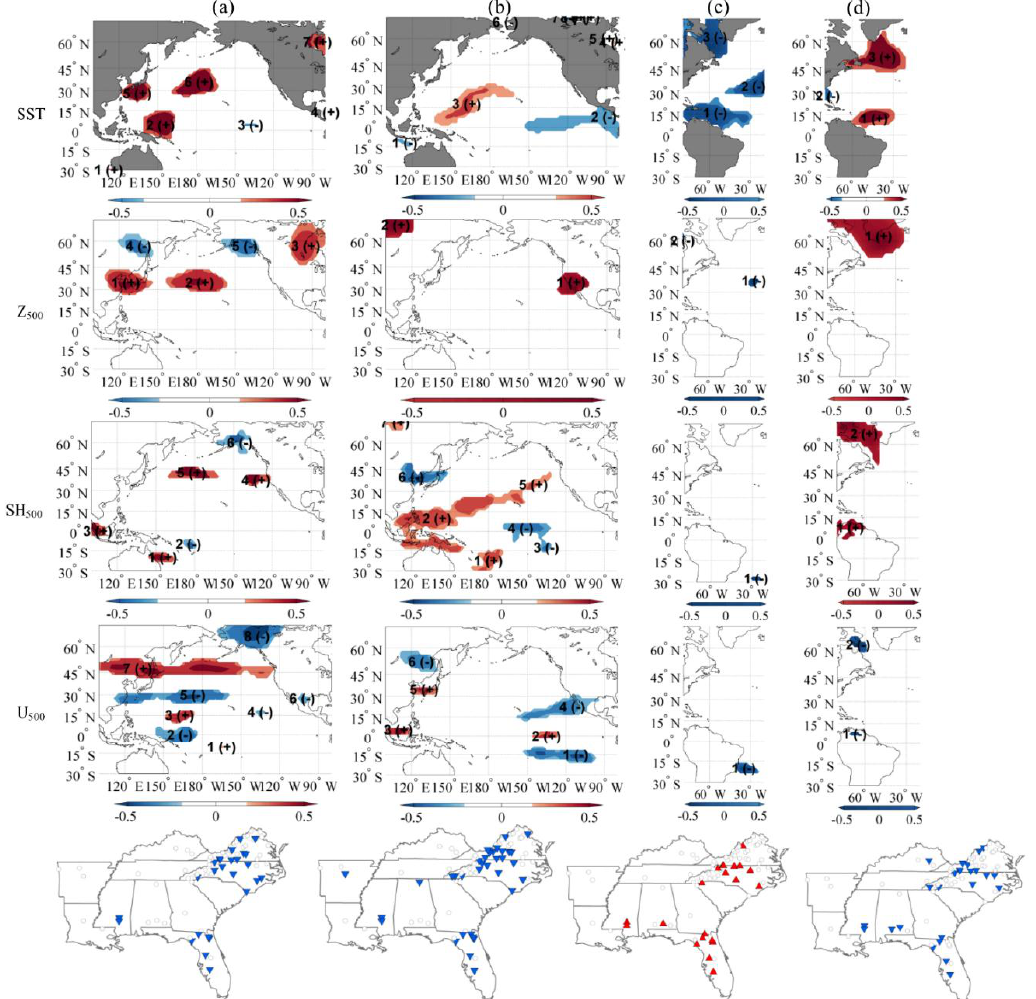
Figure 6. Heterogeneous correlation map developed for ( a ) Pacific September–November, ( b ) Pacific December–February, ( c ) Atlantic September–November, ( d ) Atlantic December–February SST, Z 500 , SH 500 , and U 500 with Southeast April–August streamflow. Significant regions with positive (negative) correlations are represented by red (blue). Significant streamflow stations are represented by red upward (blue downward) triangles.